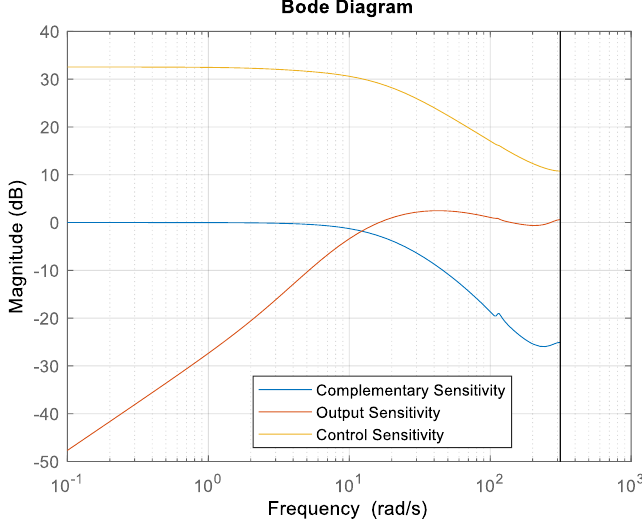
Figure 14. Sensitivities of closed-loop system with LQG controller and Kalman filter.